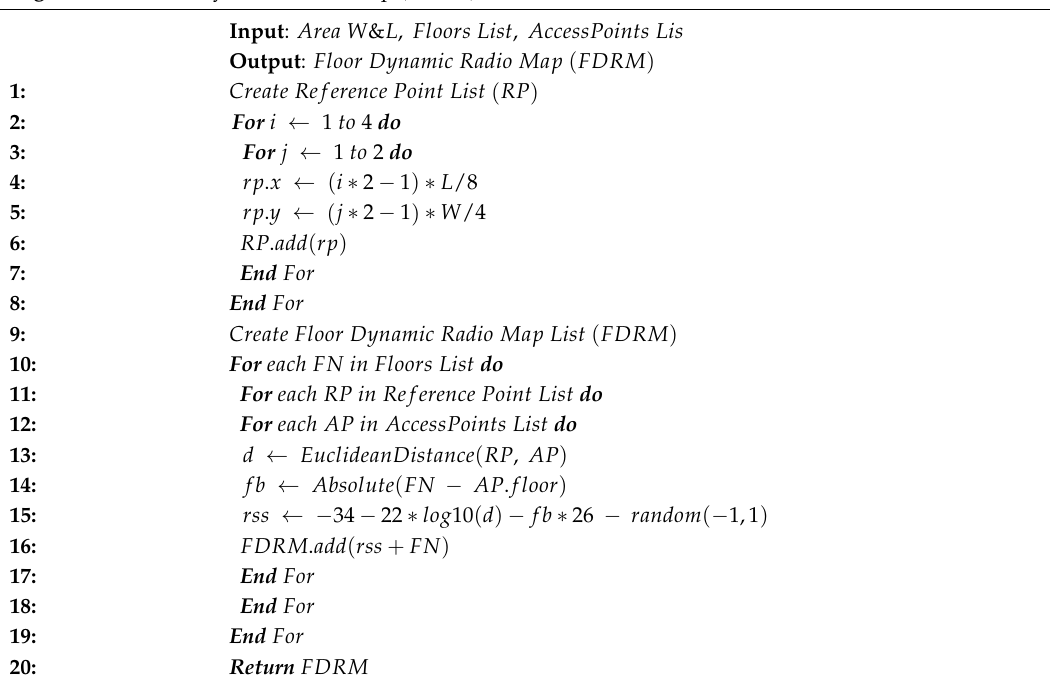
Algorithm 1: Floor Dynamic Radio Map (FDRM)